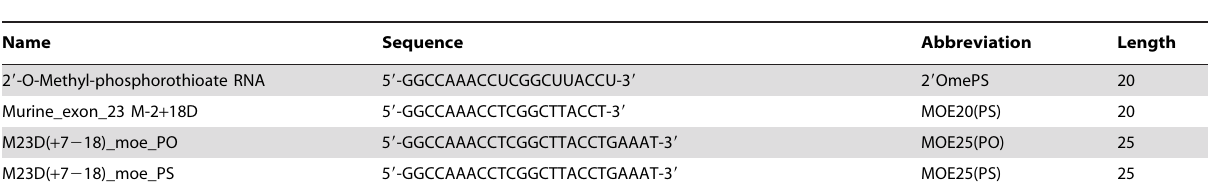
Table 1. Oligonucleotide nomenclature and